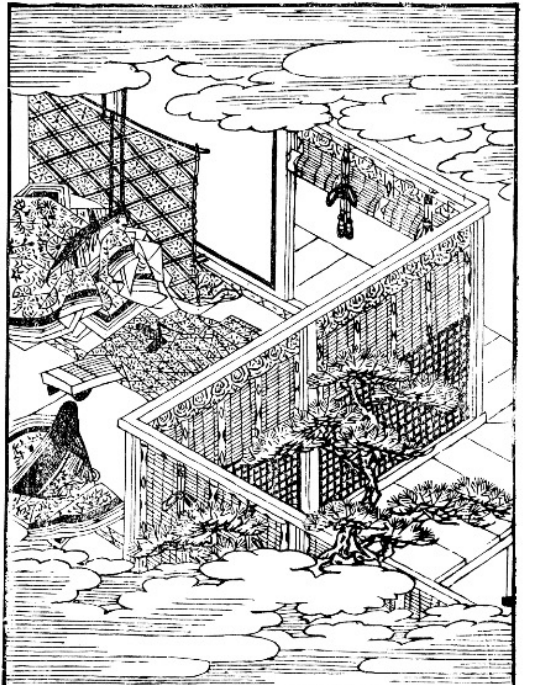
Figure 23. Saga-bon Ise episode 119. Image